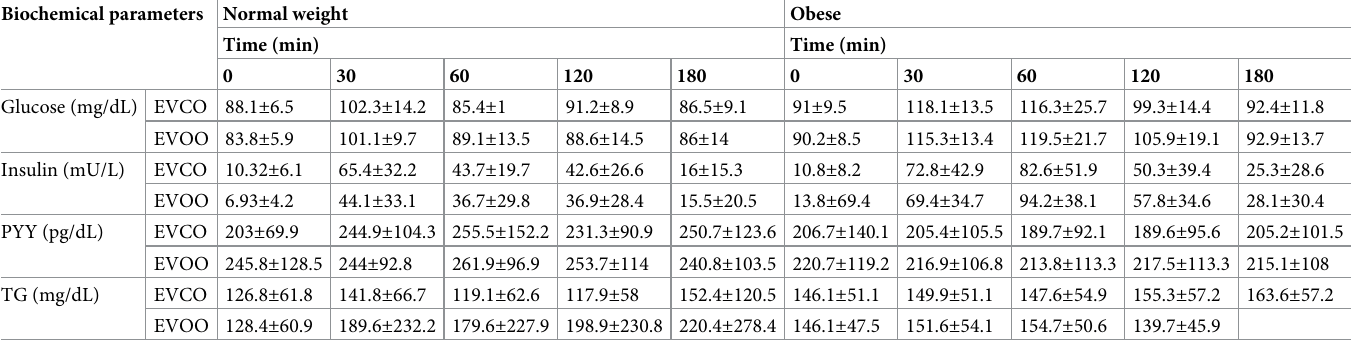
Data was presented as mean ± standard